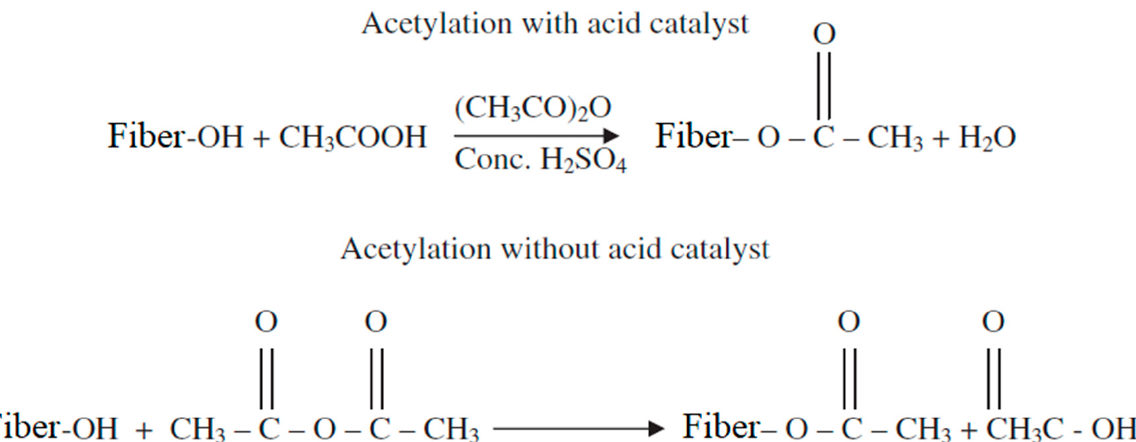
Scheme 1. Reaction mechanism of fiber acetylation with and without acid catalyst (reproduced